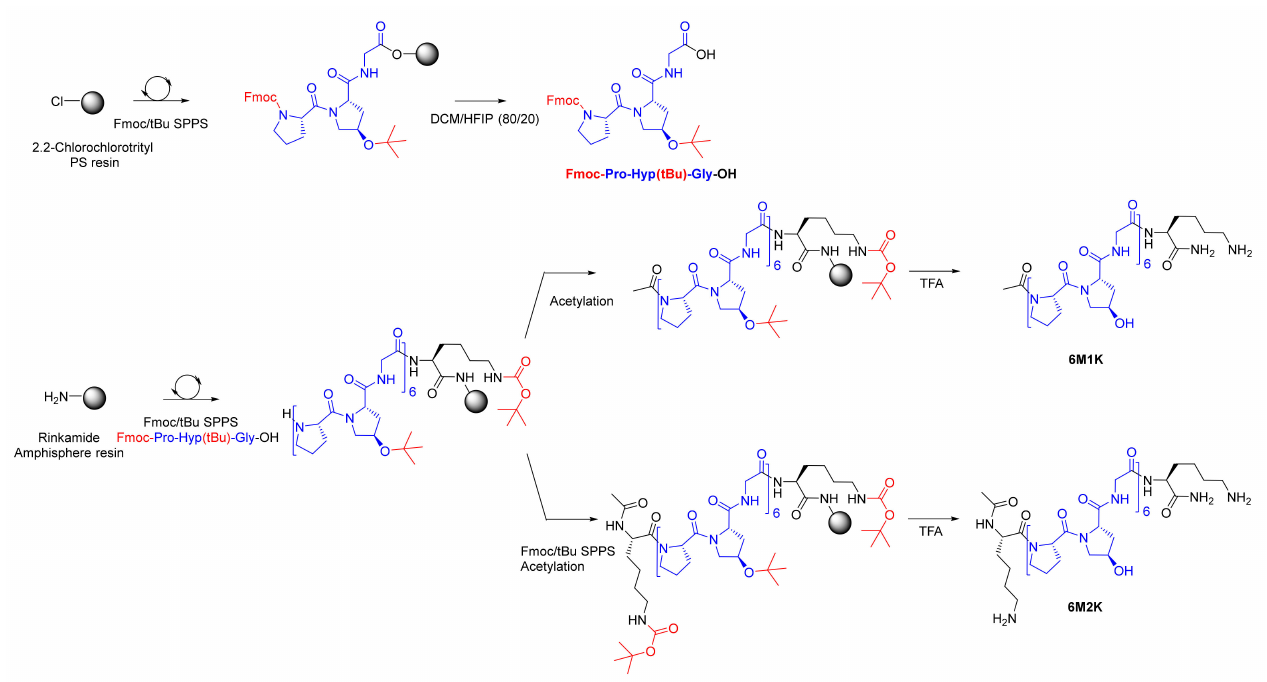
Figure 1. Synthesis of a PM block (in blue) and 6M1K / 6M2K collagen-like